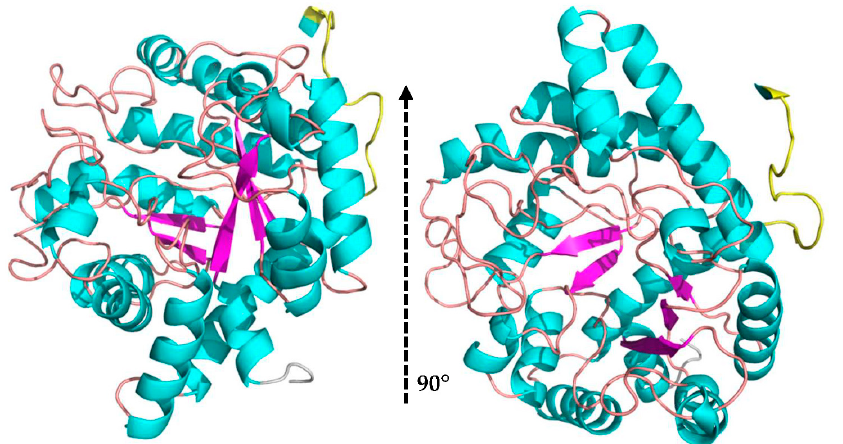
Figure 3. N-terminal domain folded as a distorted TIM barrel in the MaBgl3 model ( β / α ) 8 in a side view and upwards view (cartoon structure: α -helices in cyan, β -sheets in magenta, and loops in beige; linker loop in yellow; N-terminal end in grey color).